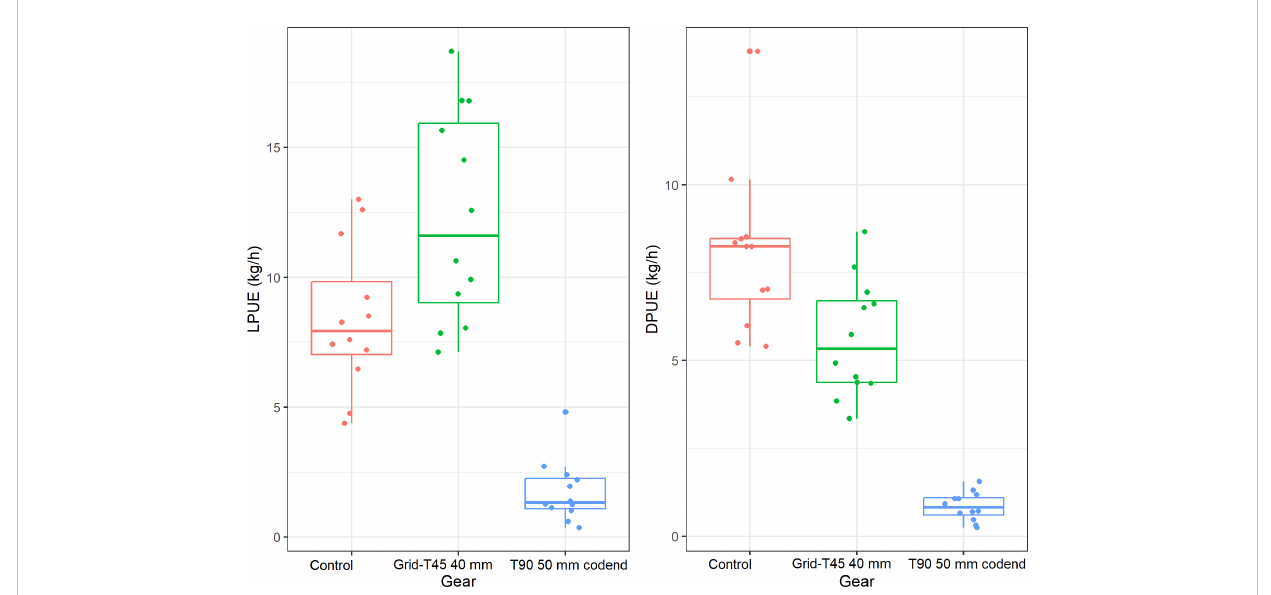
FIGURE 3 Boxplots of Parapenaeus longirostris (herein DPS) catch rates (kg/h) per gear caught during the campaign classi fi ed in landing per unit effort (LPUE; commercial) – left – and discard per unit effort (DPUE; discard) – right – according to the minimum conservation reference size (MCRS) established by the Reg. EU 1241/2019.